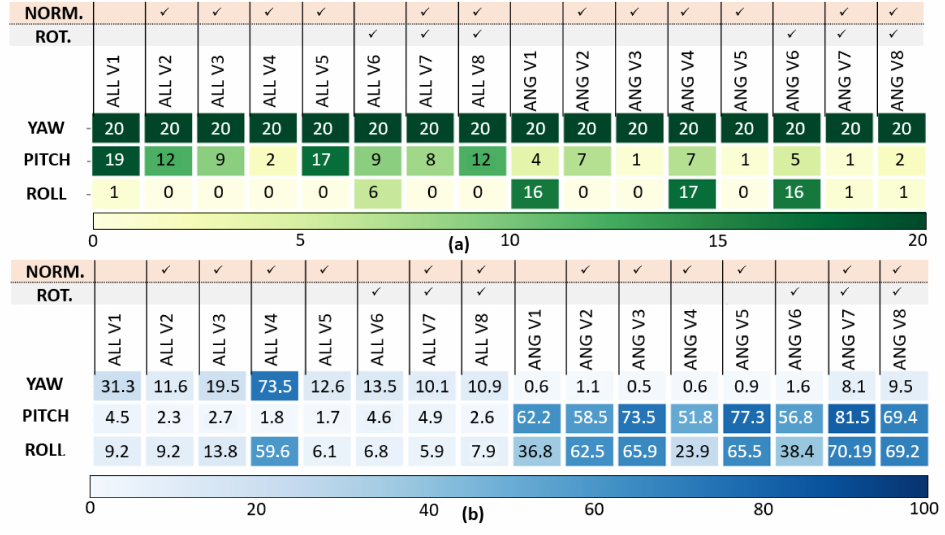
Figure 8. Orientation analysis: ( a ) Success Rate C 1 , ( b ) Error Rate C 2 (in %) of LSTM ALL , V LSTM ANG , V 1 − V 8